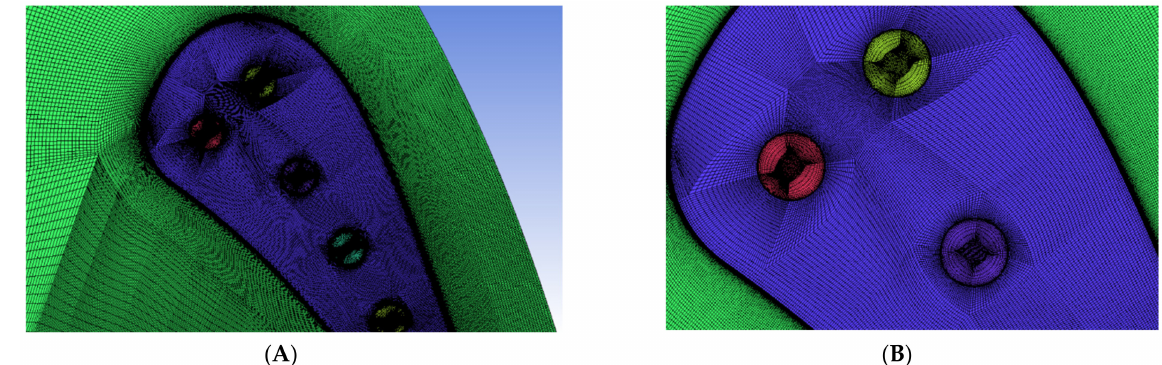
Figure 4. Mesh refinement around leading edge, ( A ) half view, ( B ) front view.